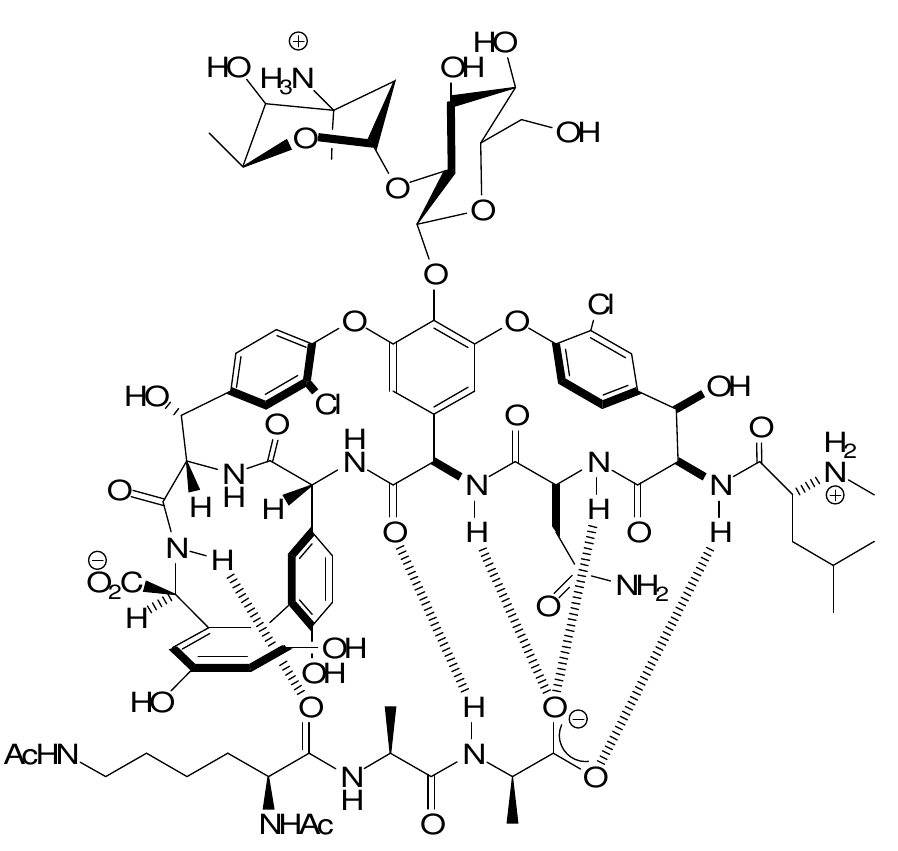
Figure 6. Schematic representation of the interactions displayed between vancomycin and the peptide Ac- L -Lys-(Ac)- D -Ala- D